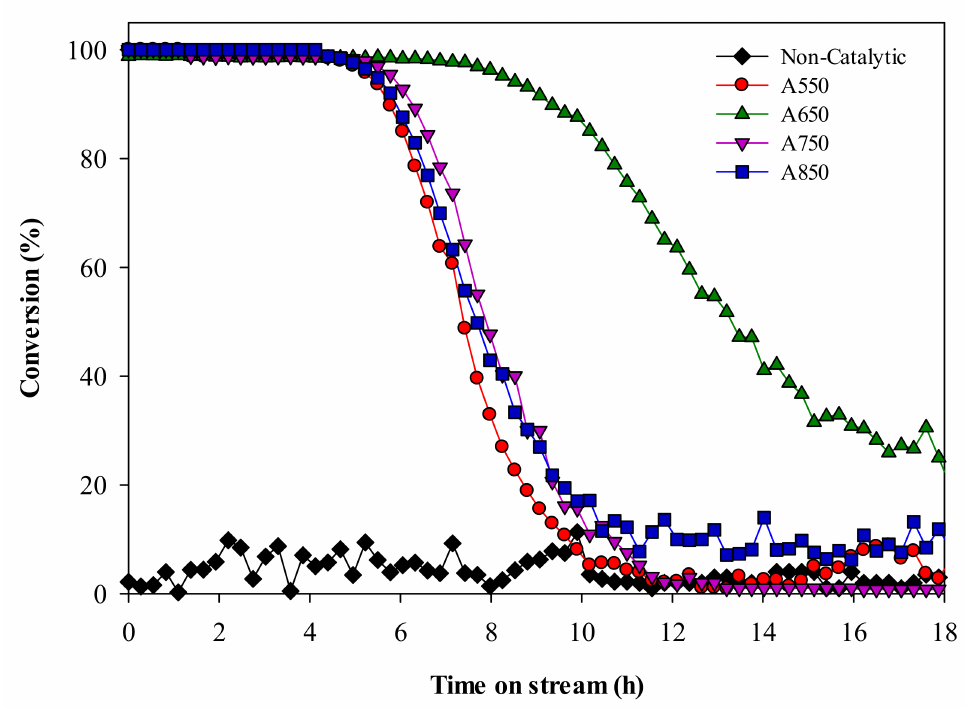
Figure 1. Thermal and catalytic conversion rate of HFC-134a over γ -Al 2 O